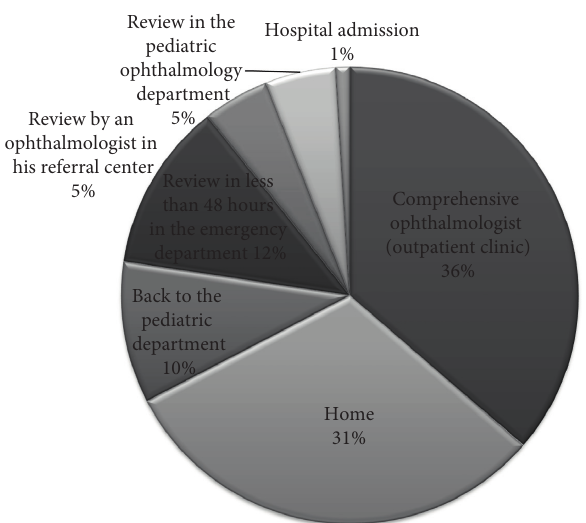
Figure 4: Final destination of children after evaluation in the